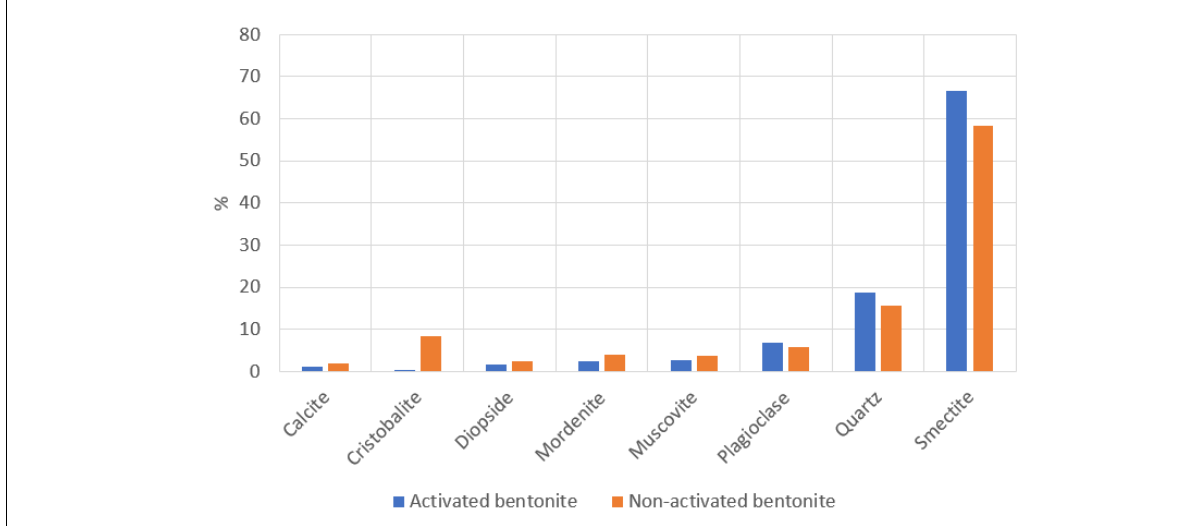
Figure 3: Mineral composition in percentages.